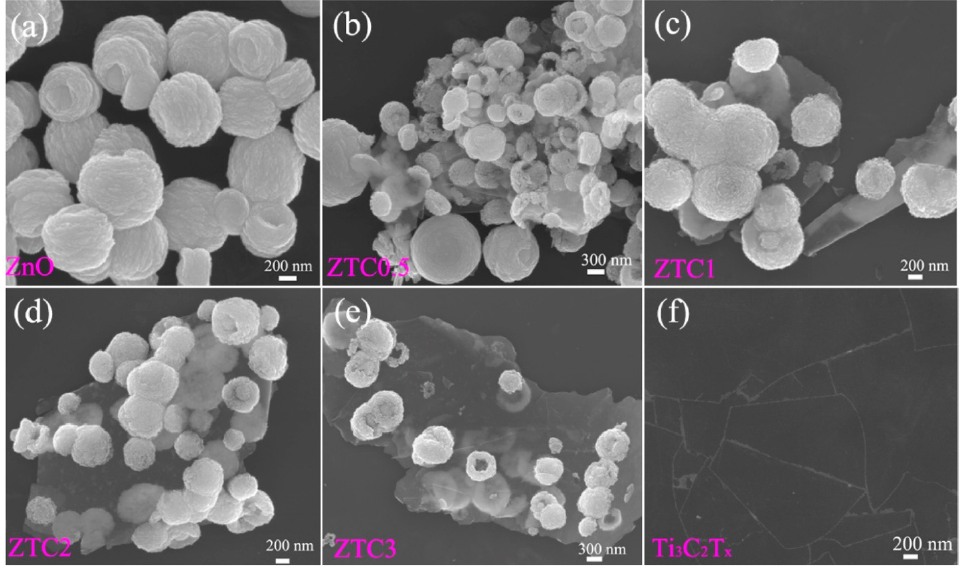
Figure 23. Morphology of the as-synthesized ZnO ( a ), ZnO/Ti 3 C 2 T x nanocomposites ( b – e ), and pure Ti 3 C 2 T x ( f ). Reprinted with permission from [126]. Copyright 2022: Elsevier B.V.